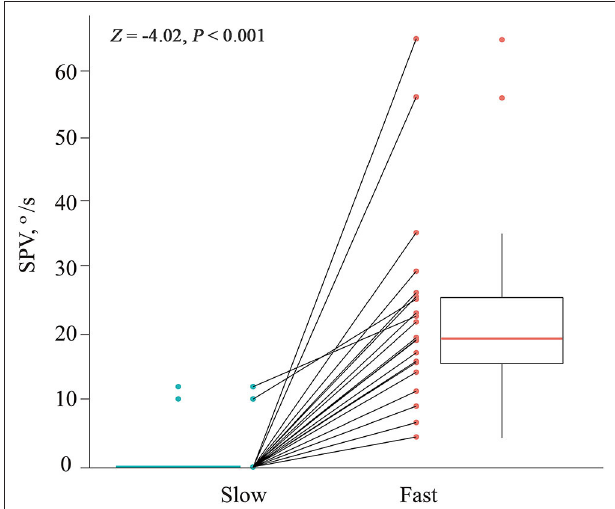
FIGURE 3 | Comparison of the maximum slow phase velocity (SPV) of paroxysmal downbeat nystagmus induced during slow and fast manual straight head hanging tests in each patient. During slow positioning, only two patients showed paroxysmal downbeat CPN, which became larger during fast positioning. In contrast, paroxysmal downbeat nystagmus was observed in all patients after fast positioning.